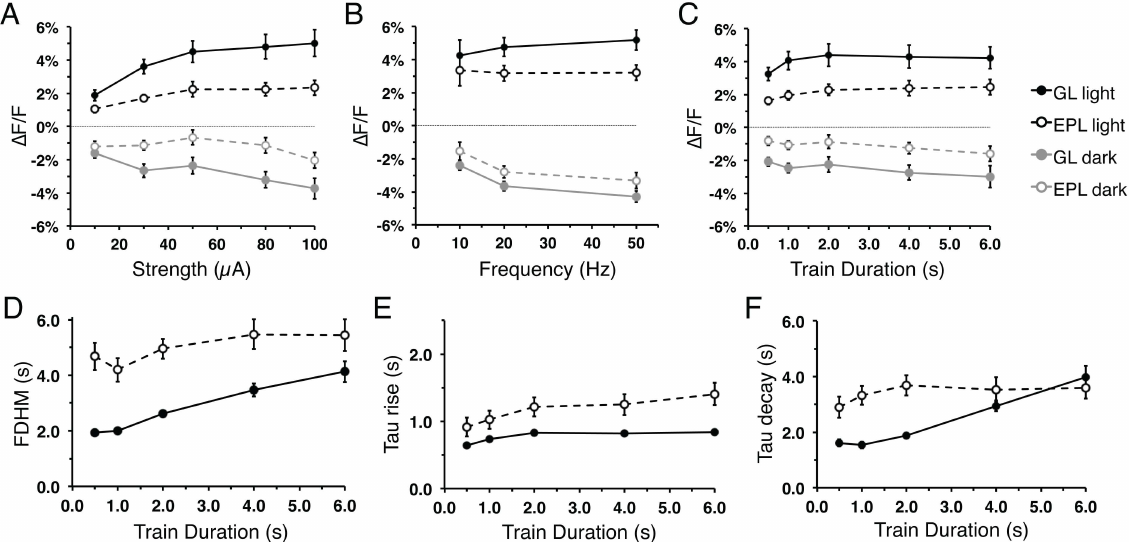
Fig 4. Flavoprotein signal responses vary with changes in stimulation parameters. (A-C) Mean flavoprotein signal amplitude of the light phase (black) and dark phase (gray) from the GL (solid) and EPL (dash) as a function of train stimulus (A) strength, (B) frequency, and (C) duration. (D-F) Flavoprotein GL and EPL light phase signal kinetics: (D) FDHM, (E) time-to-peak,and (F) time-to- trough as a function of train stimulus